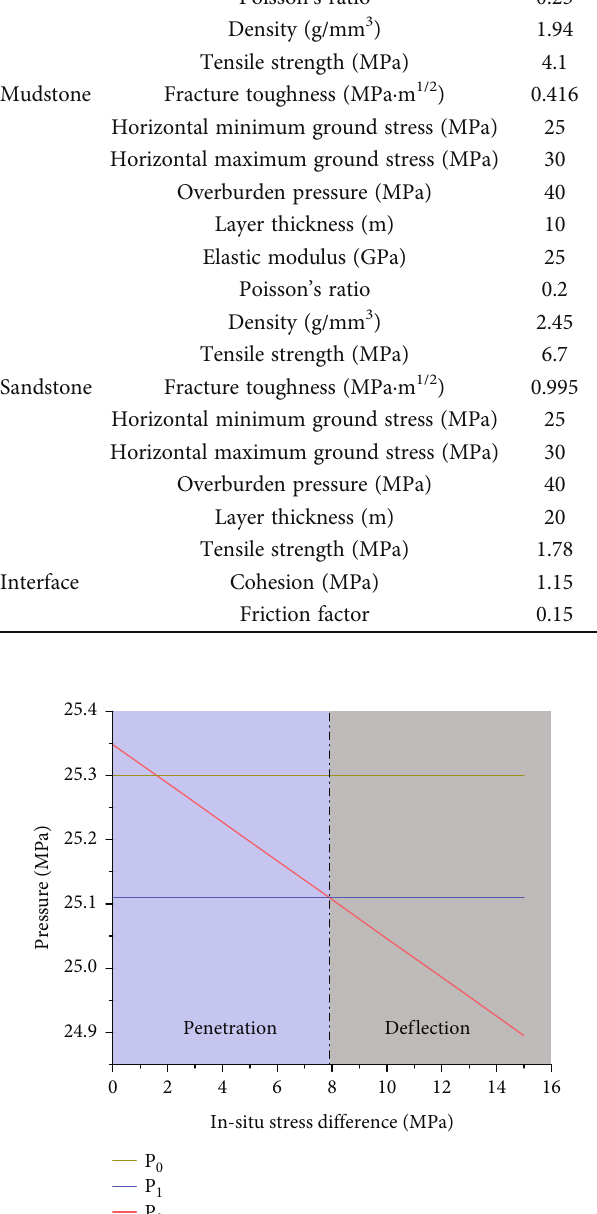
ff erent in situ stress